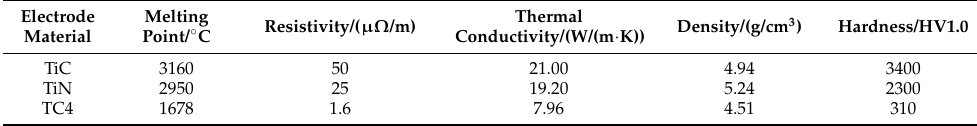
Table 6. Physical parameters of electrodes of different